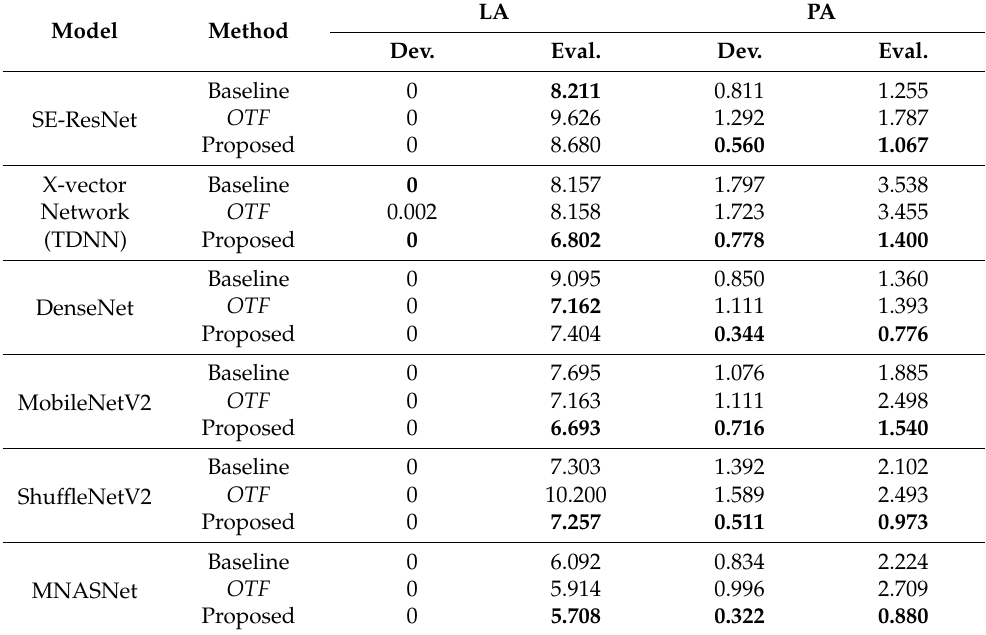
Table 5. Oracle EERs (%) of systems in the development and evaluation trials of ASVspoof 2019 LA and PA, with three different methods (i.e., baseline, OTF , and proposed). For each model, the lowest EER is highlighted in